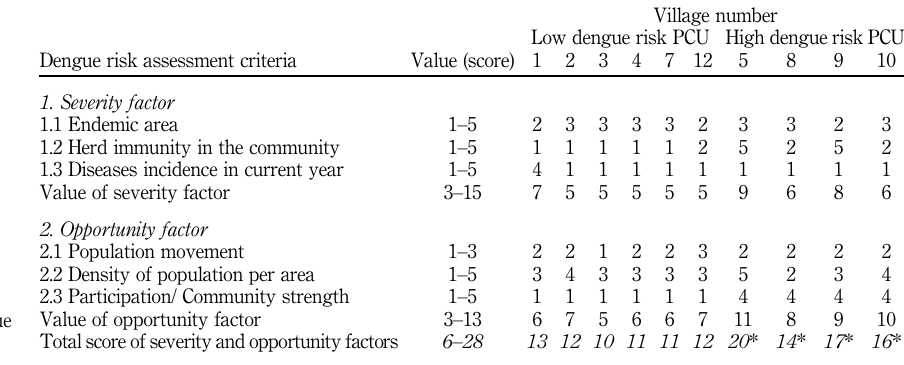
Table I. Village ’ s areas with low and high dengue risk